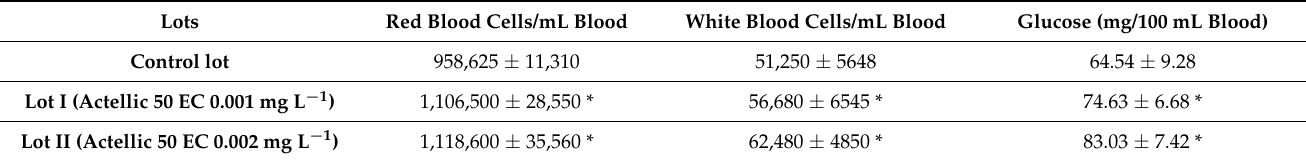
Table 7. Mean number of figure elements and glucose with standard deviations in carp exposed to Actellic 50